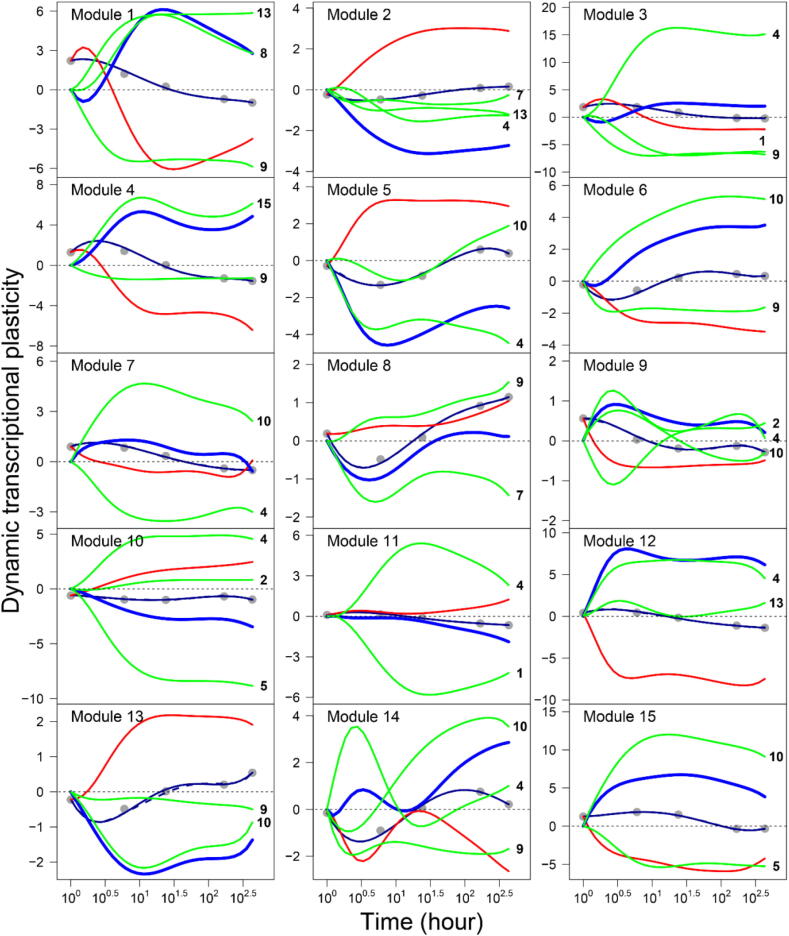
Mean dynamic transcriptional plasticity (DTP) curve of all genes within each module (black solid line) fitted by a nonparametric Legendre orthogonal polynomial (LOP) approach, which is dissected into its independent DTP curve (red line) and dependent DTP curve regulated by other labeled modules (green line). The thick blue line is the summed dependent DTP of all interacting modules. (For interpretation of the references to colour in this figure legend, the reader is referred to the web version of this article.)